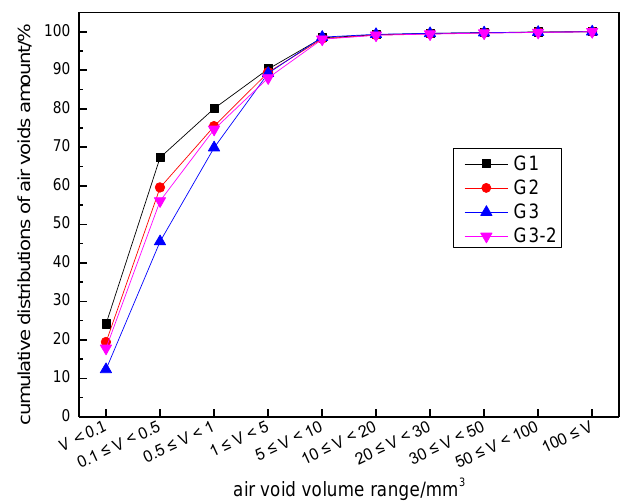
Figure 9. Cumulative distributions of air void amounts with different mixtures.